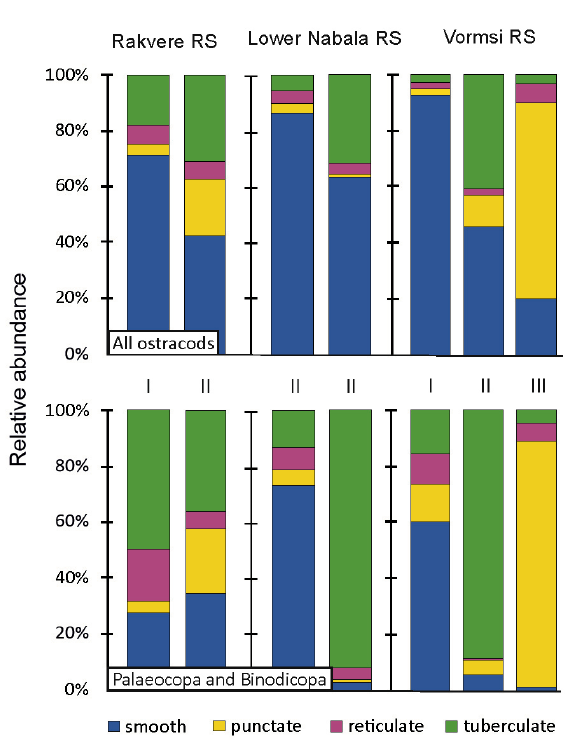
Fig. 12. Valve ornamentation (average relative abundances) in the formations of the analysed regional stages. Upper graph – valve ornamentation of all ostracods; lower graph – valve ornamentation of palaeocopes and binodicopes; I – mixed facies, II – mud-supported facies, III – black shale